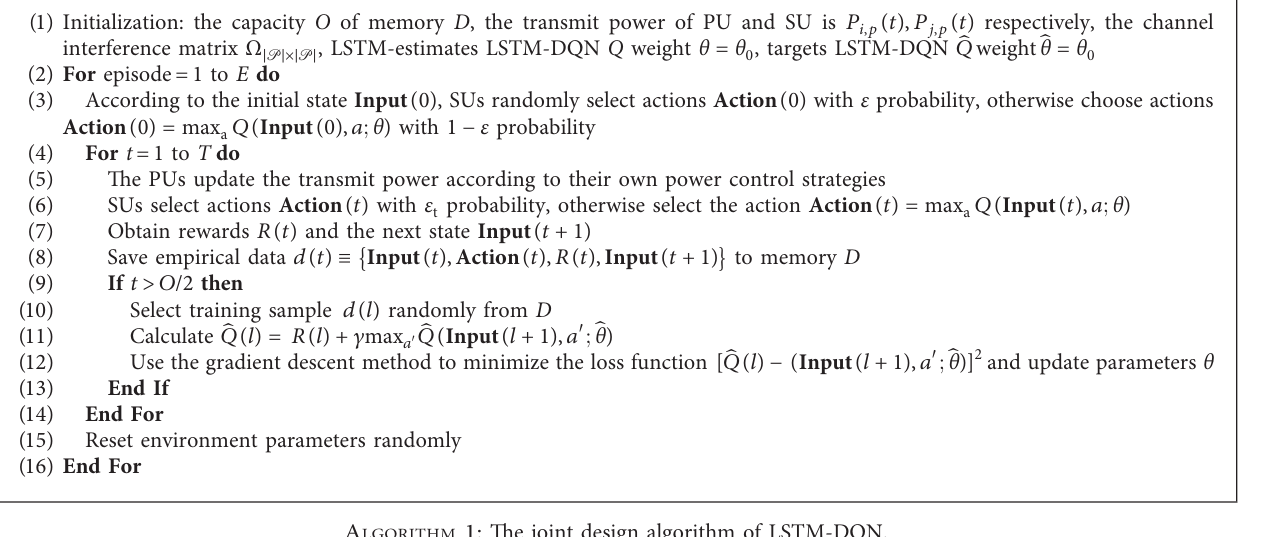
A LGORITHM 1: The joint design algorithm of